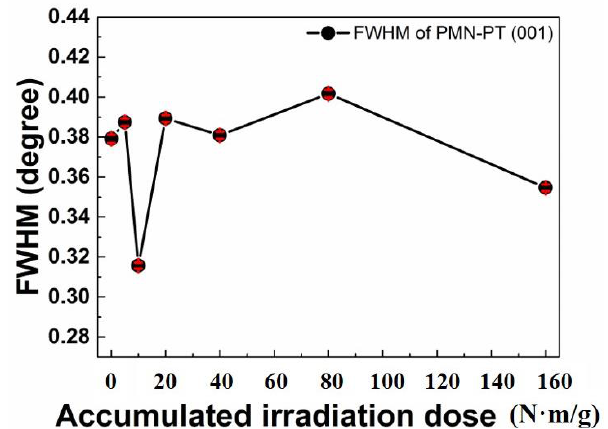
Figure 3. Variation of full width at half maximum (FWHM) at (001) plane of PMN-28%PT in accordance with the accumulated neutron irradiation does.